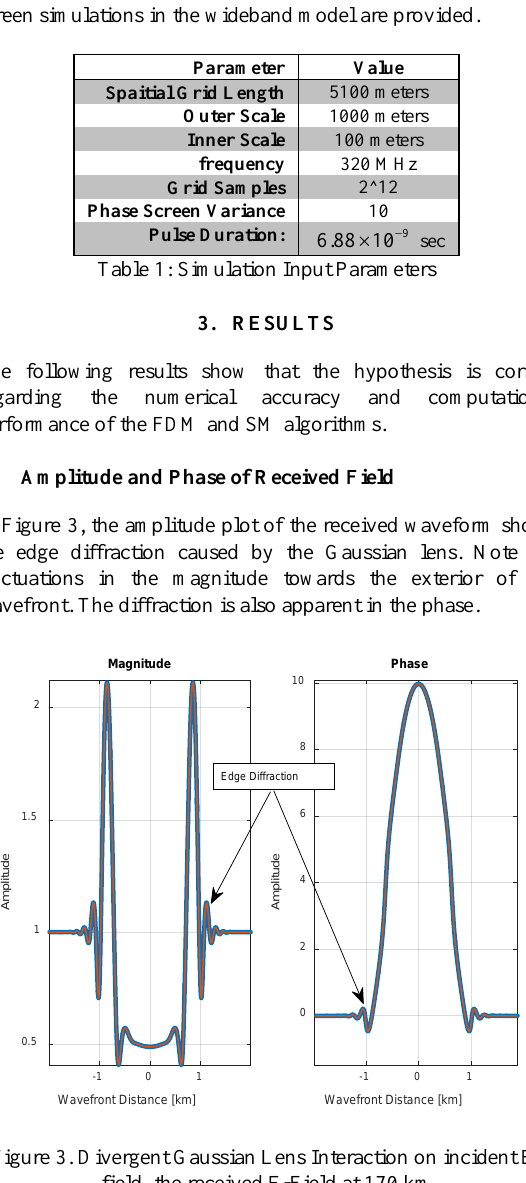
Figure 3. Divergent Gaussian Lens Interaction on incident E-